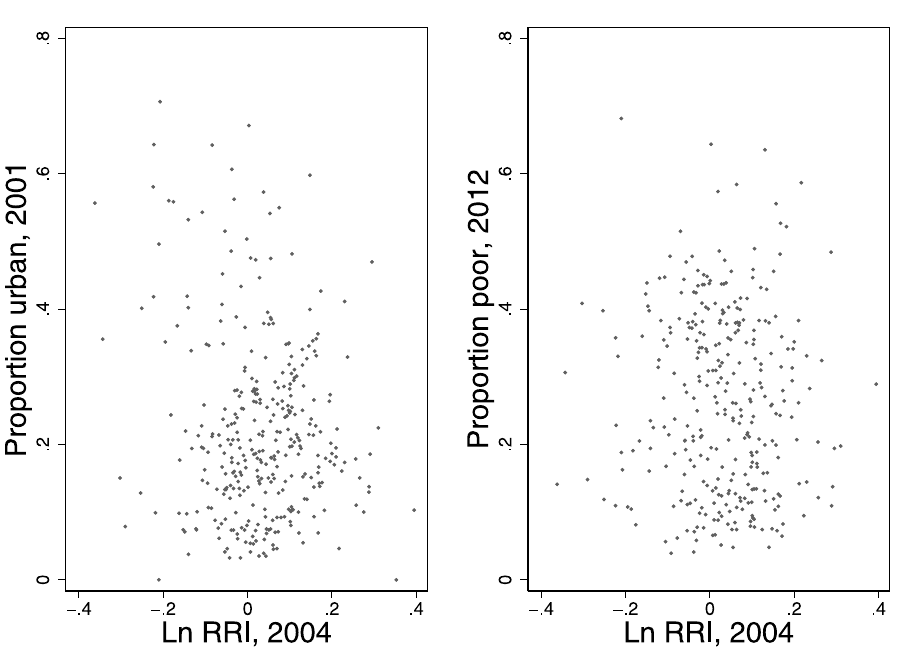
Fig 2. The relative representation index, urbanization and